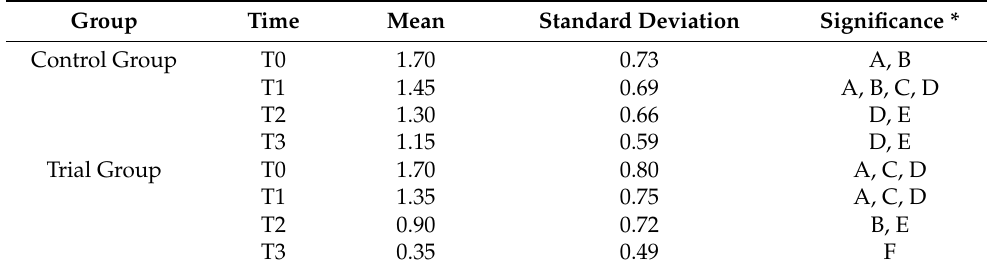
Table 3. Descriptive statistics of SAI measurements.